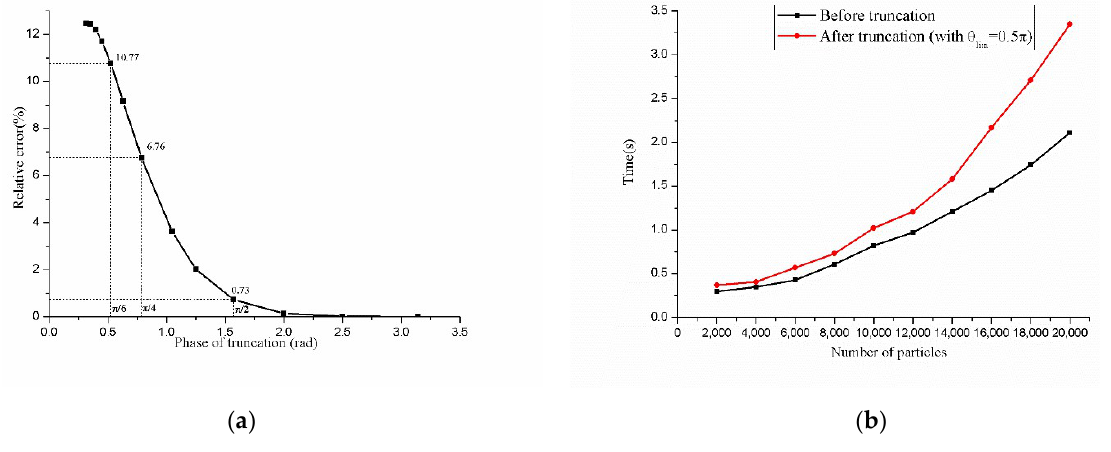
Figure 12. ( a ) The relative error of the output power with different θ lim . ( b ) The calculation time